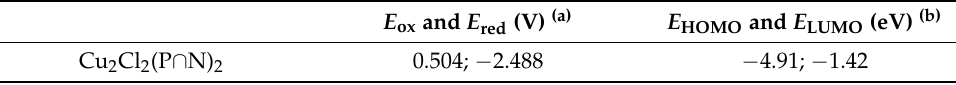
Table A1. Electrochemical properties of Cu 2 Cl 2 (P ∩ N) 2